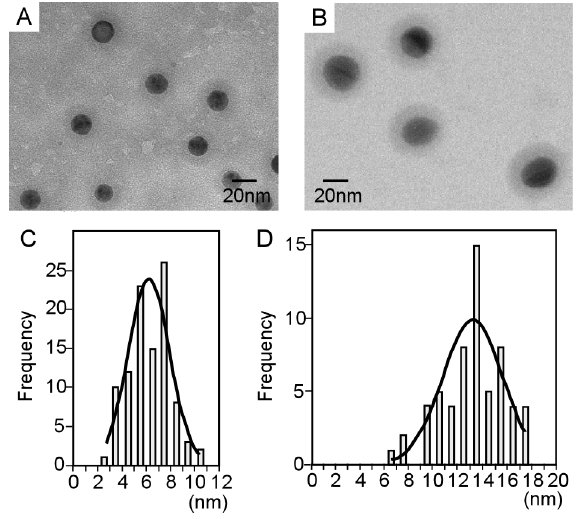
Figure 2. Electron microscopic images and distribution of silica thickness on fluorescent nanoparticles of 20 and 40 nm. (A) Electron microscopic image of 20 nm fluorescent nanoparticles with silica coating. (B) Electron microscopic image of 40 nm fluorescent nanoparticles with silica coating. (C) Distribution of silica coating thickness on 20 nm fluorescent nanoparticles. (D) Distribution of silica coating thickness on 40 nm fluorescent nanoparticles.